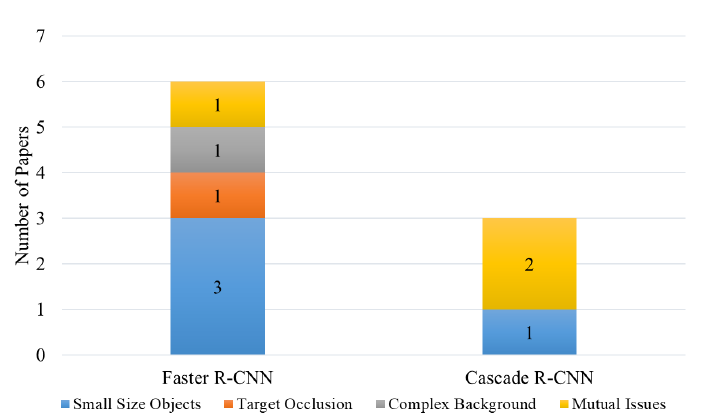
Figure 17. Classification of Two-Stage Detectors in